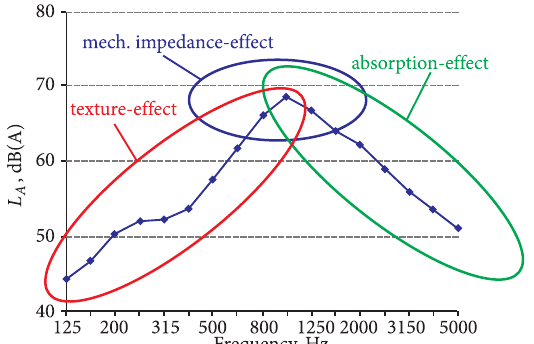
Fig. 5 . A typical rolling noise spectrum and the frequency range of influence of the three main road parameters: texture, absorption and mechanical impedance (Kuijpers, Van Blokland